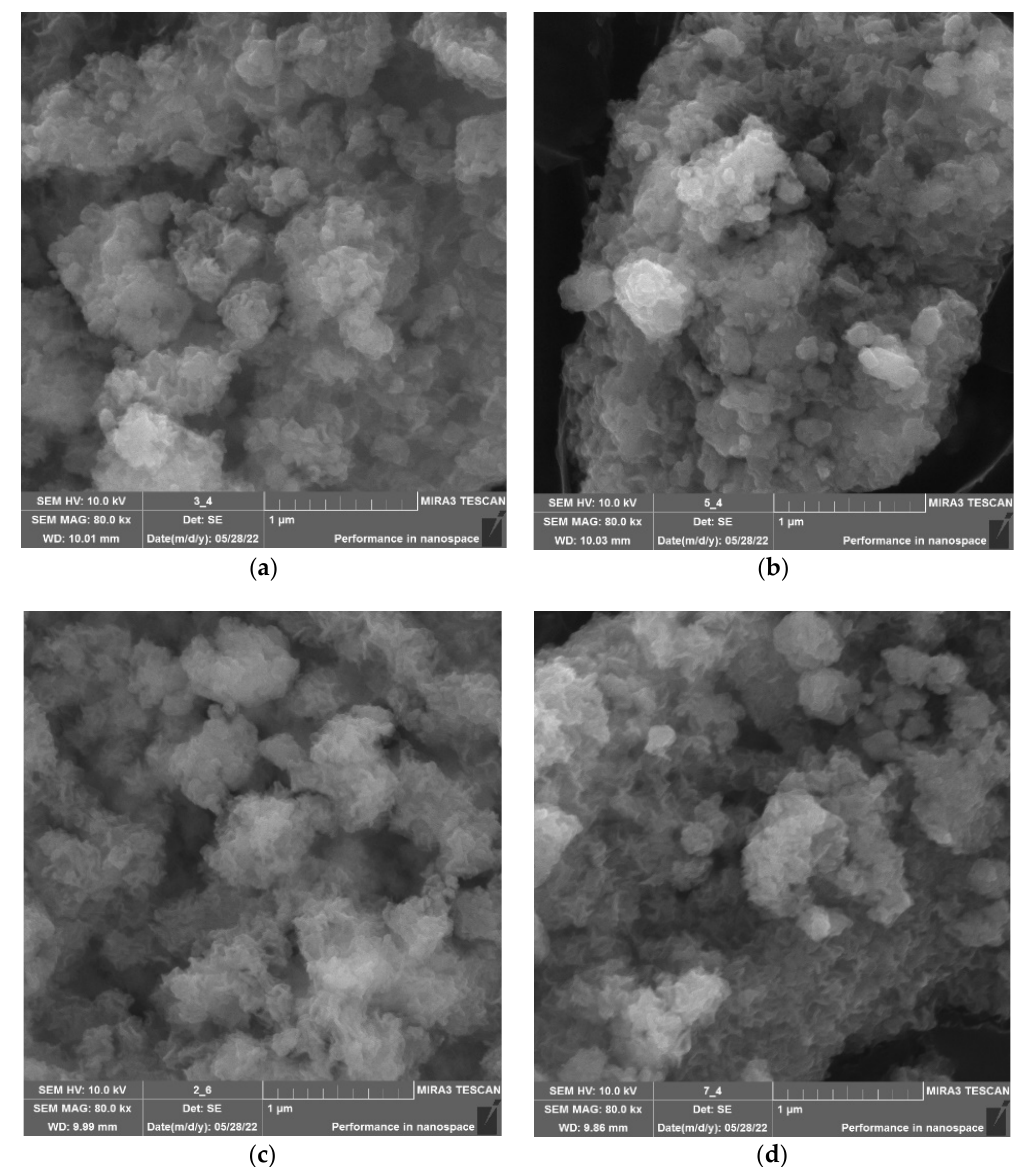
Figure 5. SEM micrographs of calcium silicate stabilized by: ( a ) L-phenylalanine, ( b ) L-leucine, ( c ) L-methionine, ( d ) L-threonine.